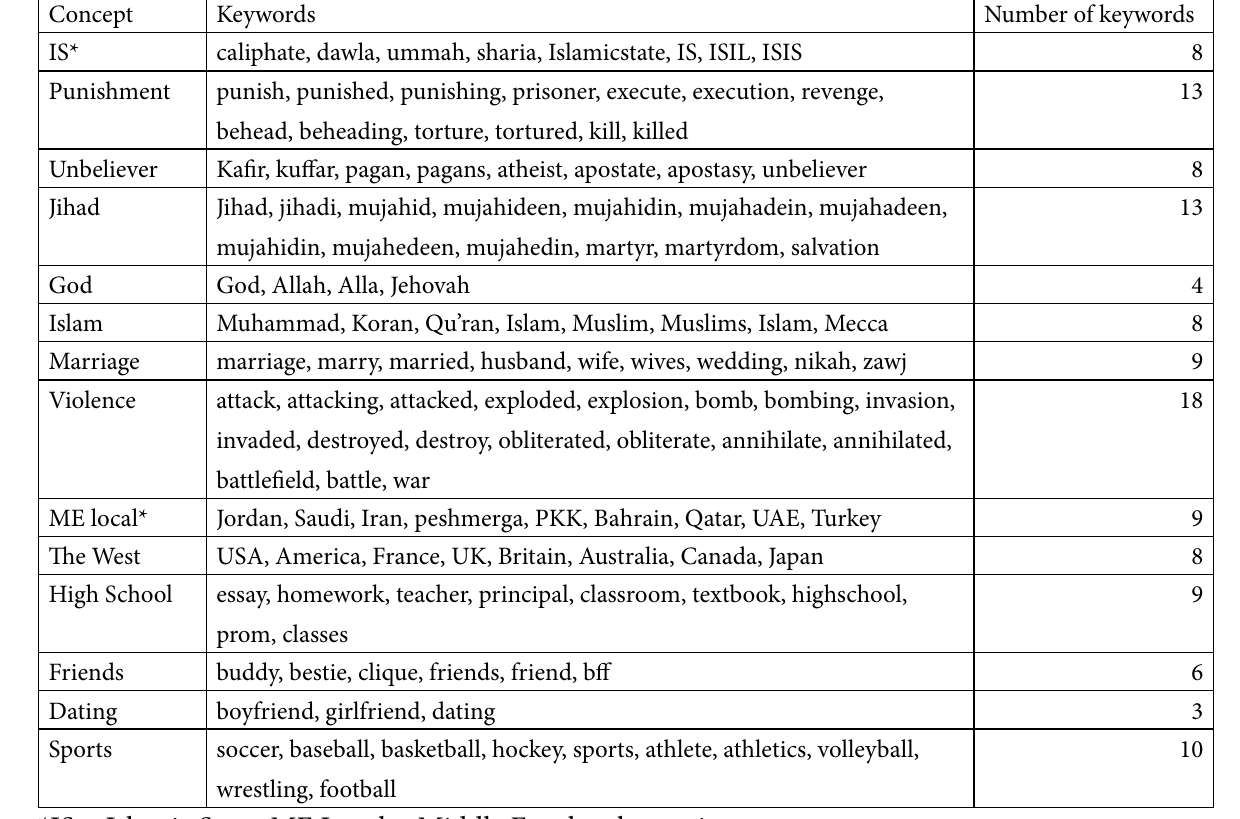
Table 1: The 14 content-related concepts along with their keywords. Concept